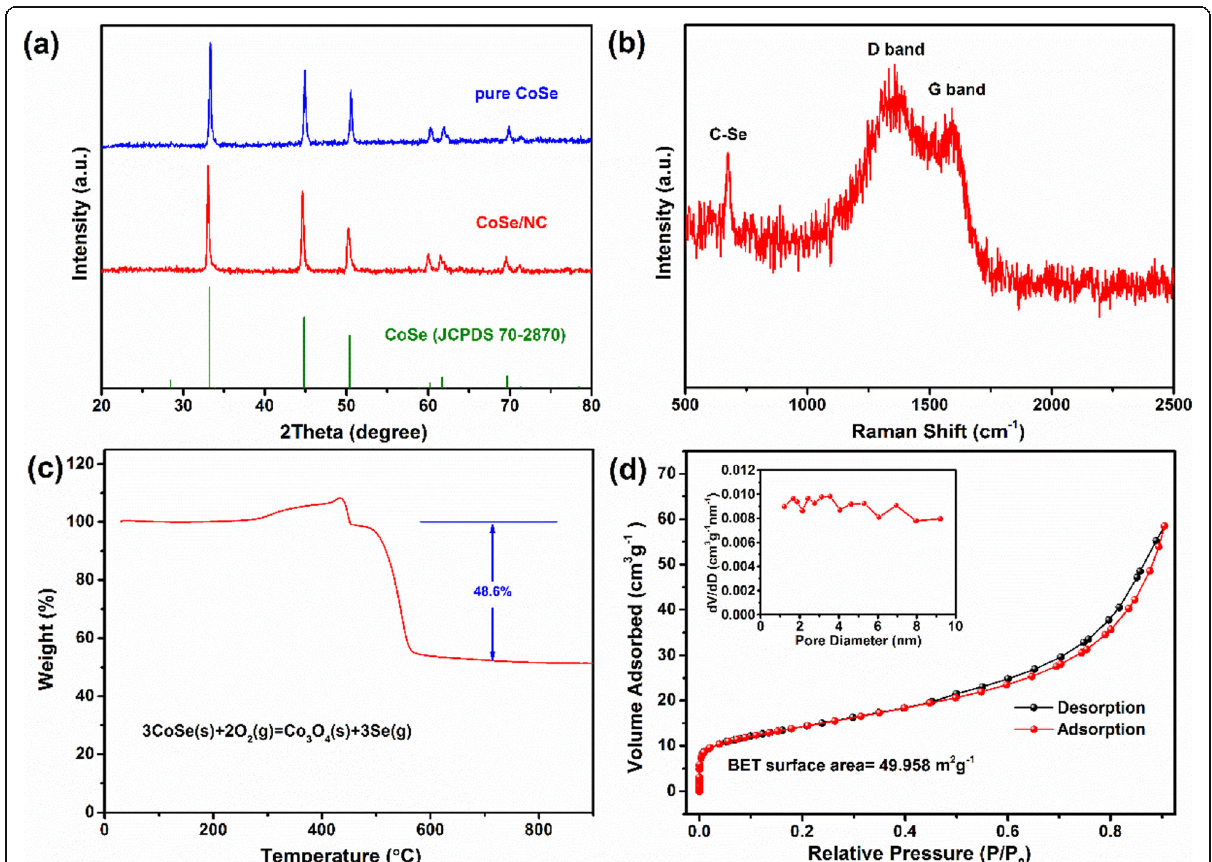
Fig. 3 a XRD patterns of CoSe/NC and pure CoSe. b Raman spectrums of CoSe/NC. c TGA curve of CoSe/NC. d Nitrogen adsorption-desorption isotherm and diameter distribution profiles of